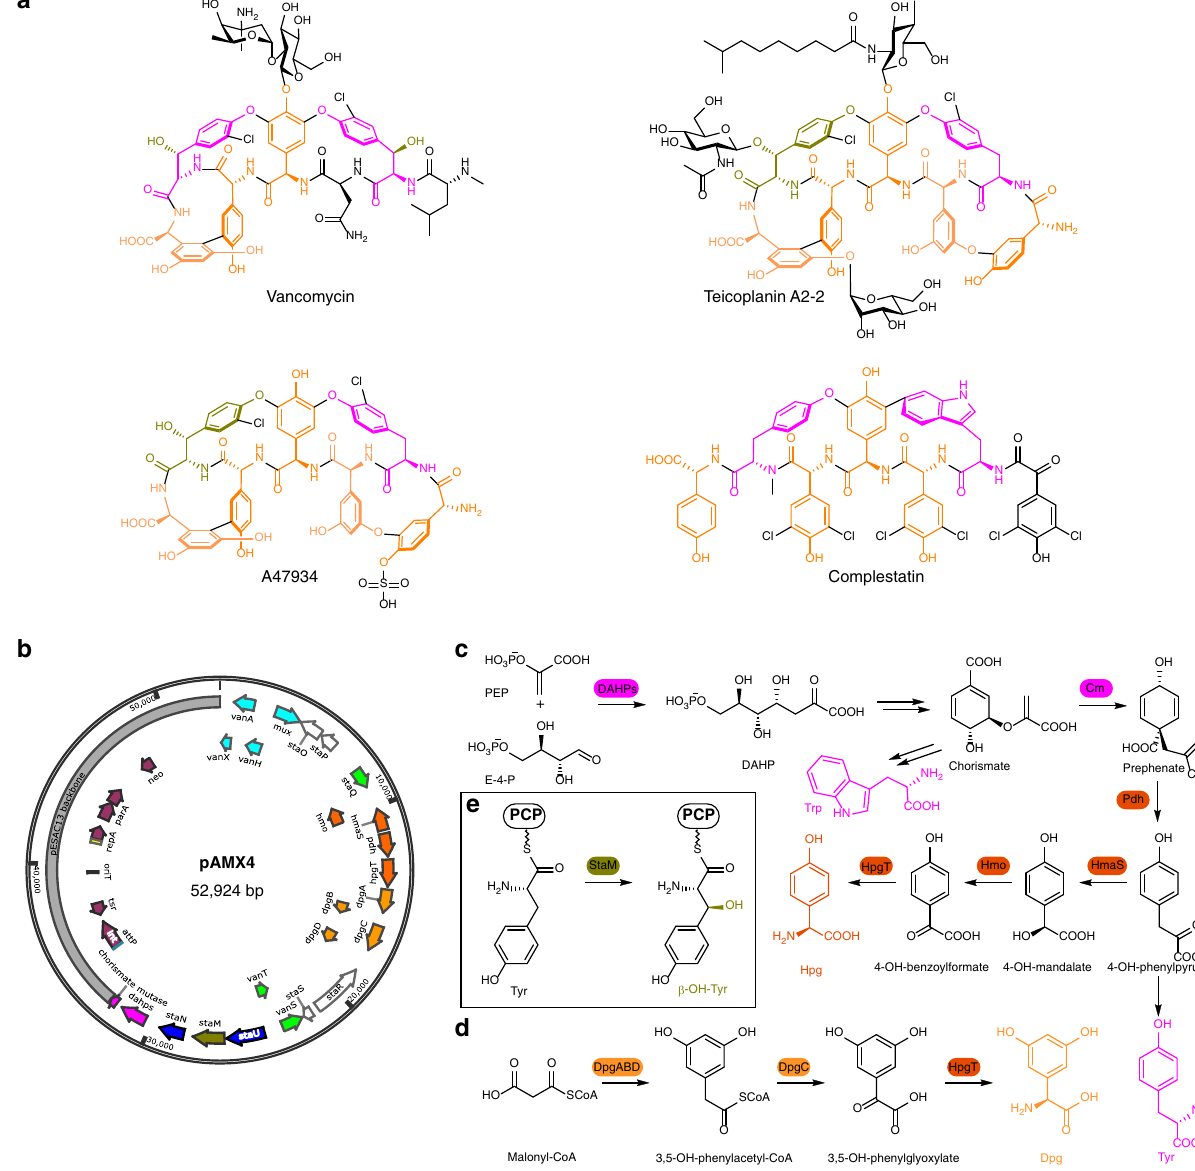
Fig. 1 GPA representatives and biosynthesis of aromatic building blocks for GPAs. a Representatives of GPAs. b pAMX4 bearing the GPA synthetic cassettes originated from the A47934 BGC for making the GPAHex production chassis. Genes are colored according to their functions: cyan (resistance), white (unknown), green (regulation), dark orange (Hpg biosynthesis), orange (Dpg biosynthesis), blue (transportation), olive (Bht biosynthesis), pink (Tyr/ Trp/Hpg biosynthesis), and gray (pESAC13 plasmid backbone). c Biosynthetic pathway for producing Trp, Tyr, and Hpg. d Biosynthetic pathway for producing Dpg. e Biosynthetic pathway on pAMX4 for producing Bht. Aromatic amino acids are colored according to their biosynthetic